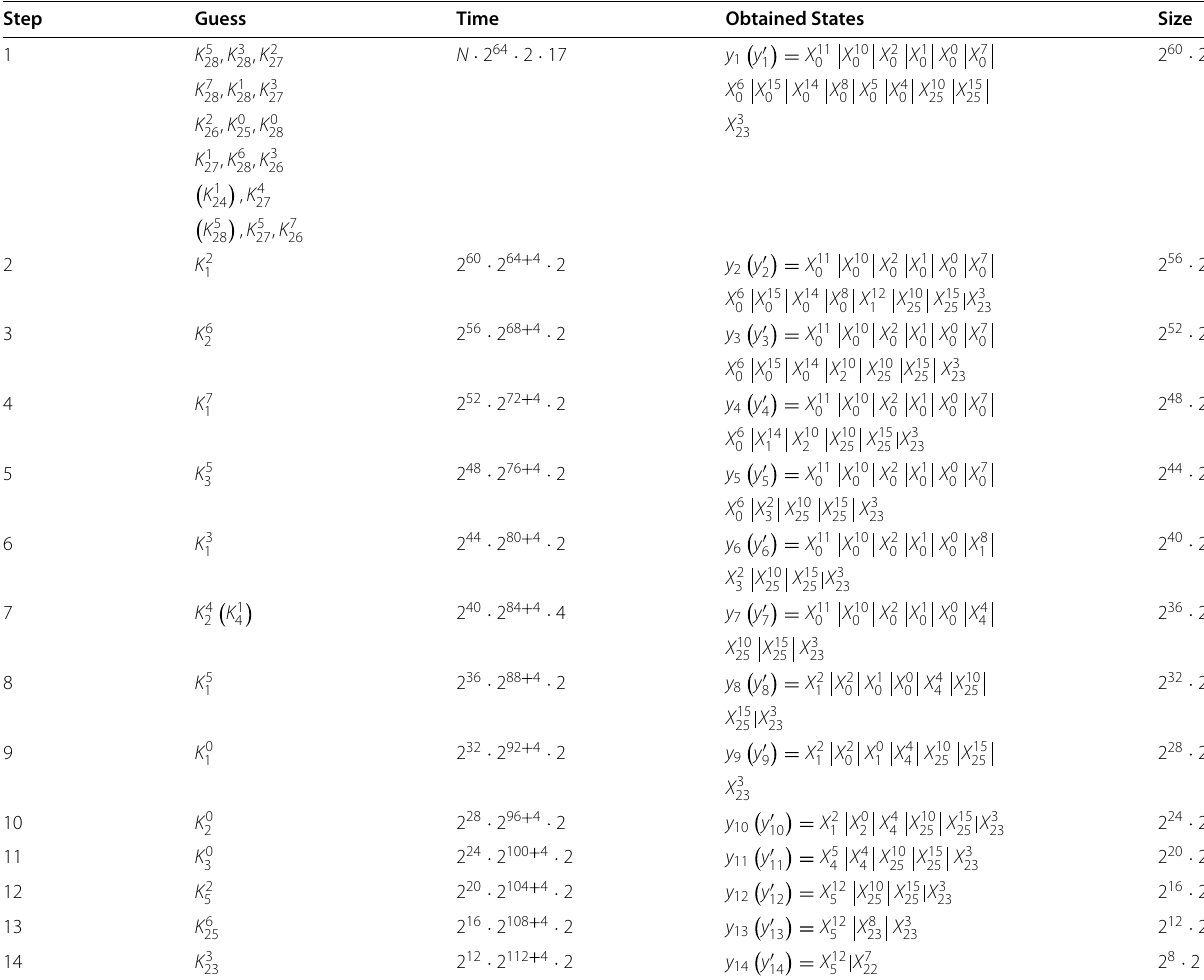
Table 6 Partial encryption and decryption on 28-round TWINE-128 Step Guess Time Obtained States Size